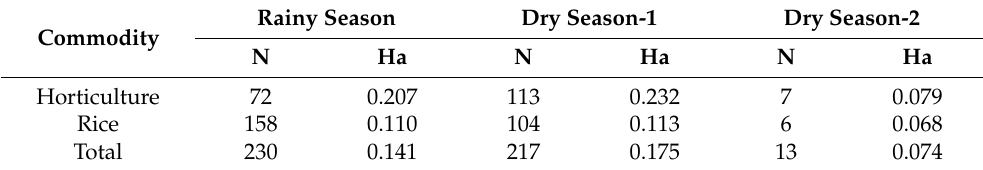
Table 3. Number of Plot and Average Size of Owned Plots Planted with Seasonal Crops by Season. Rainy Commodity